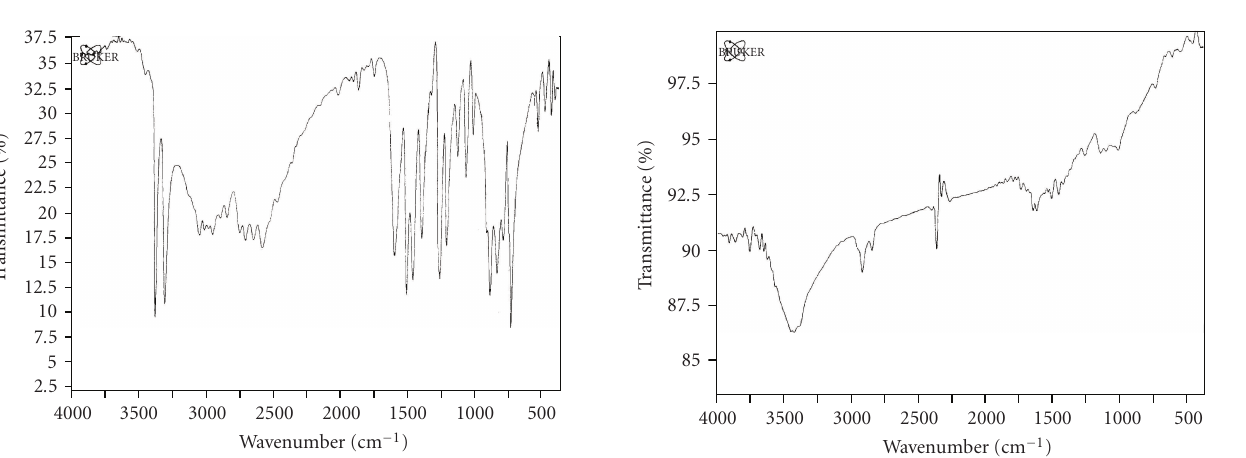
Figure 5: IR spectrum of natural rubber-g- o -aminophenol (NR-g- o -AP).